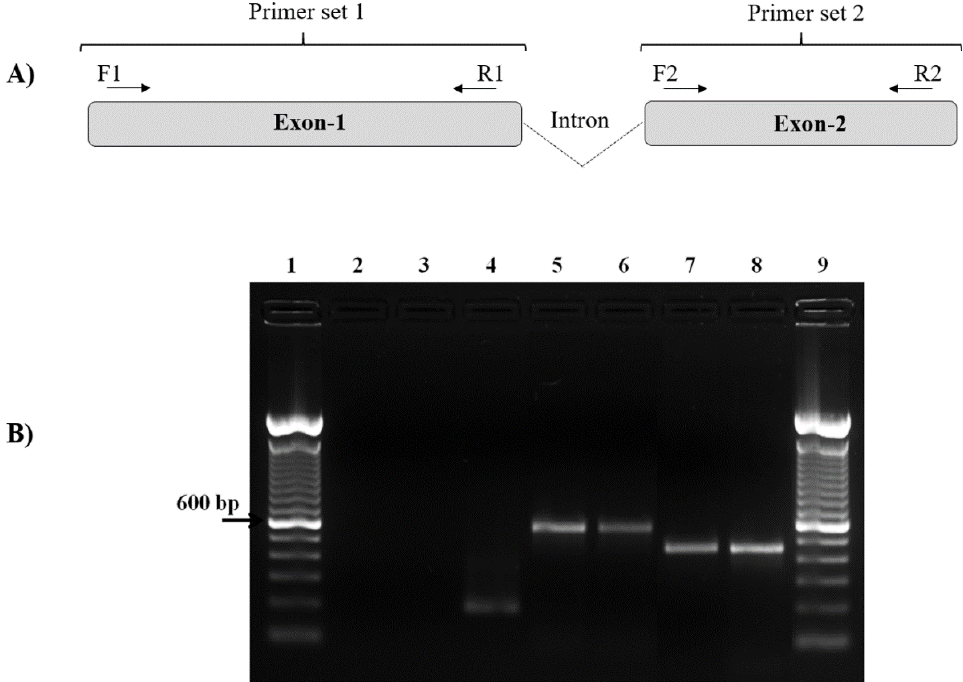
Figure 1. Molecular detection of the pvcyrpa gene by PCR. ( A ) Schematic representation of pvcyrpa gene, showing the fragments (exons 1 and 2) that were successfully amplified by two different primers sets (PvCyRPA F1/R1 and PvCyRPA F2/R2). ( B ) PCR amplification of the pvcyrpa gene. The figure shows agarose gel of pvcyrpa fragments amplified using PvCyRPA_F1/R1 primer and PvCyRPA_F2/R2 primer sets, respectively: Lane 1 and 9:100 bp molecular marker; Lane 2: negative